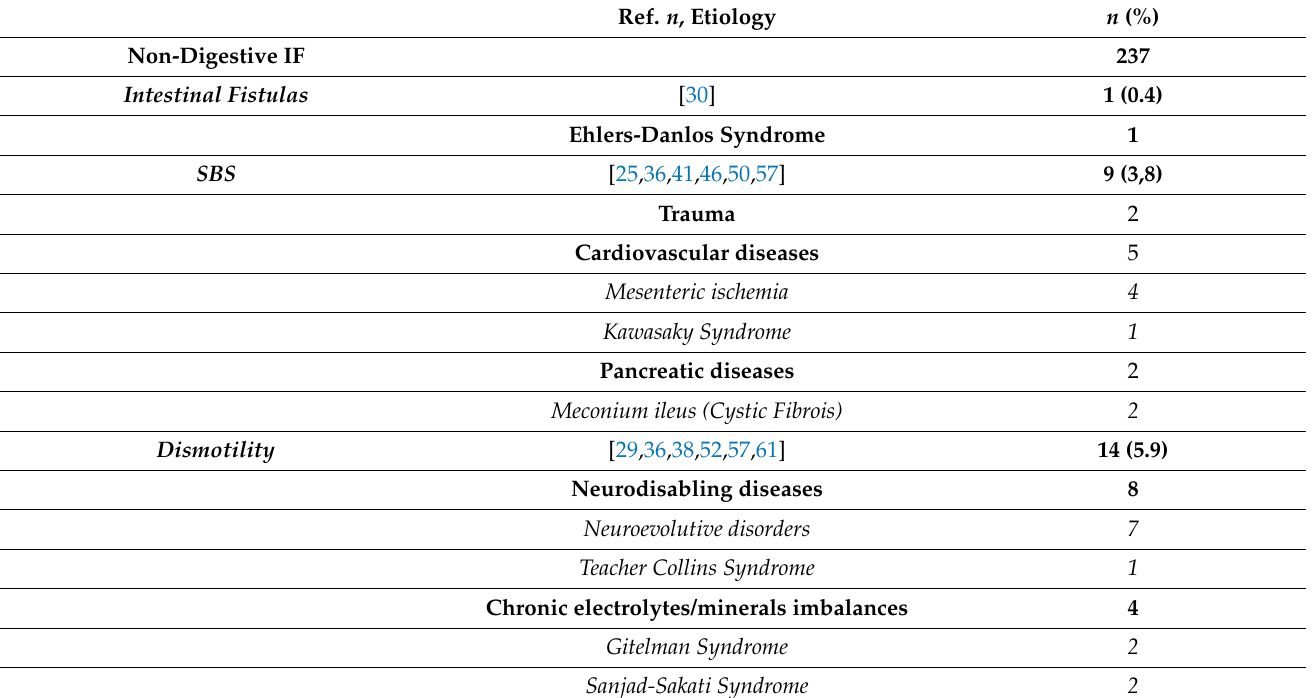
Table 3. Summary of the causes of Non-digestive Intestinal Failure